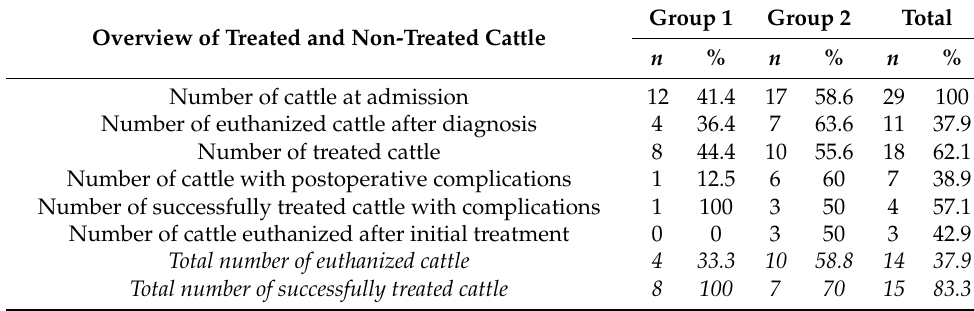
Table 2. Overview of 29 cattle with septic bursitis of the SCB divided into group 1 (septic SCB only) and group 2 (septic SCB with concurrent bone and SDFT involvement), number of euthanized cattle, number of treated cattle, number of cattle with postoperative complications and cattle with